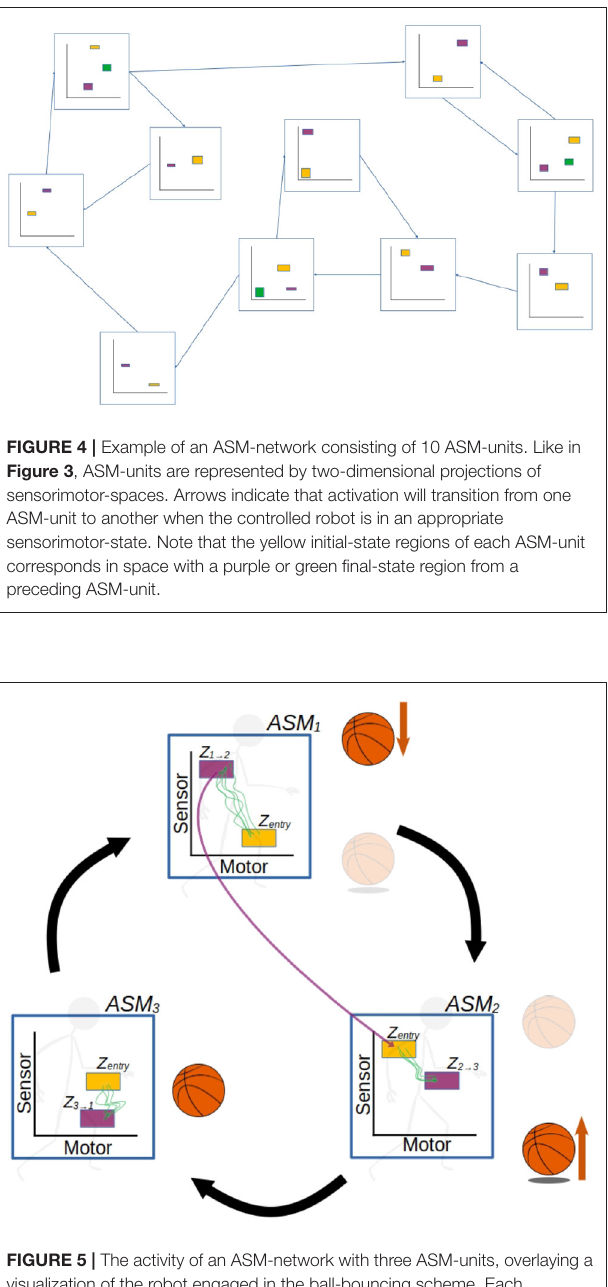
FIGURE 5 | The activity of an ASM-network with three ASM-units, overlaying a visualization of the robot engaged in the ball-bouncing scheme. Each ASM-unit simulates a particular sequential component of the dynamics involved in the robot’s side of the coupling. Each activation of the ASM-unit yields the necessary state for the activation of the next ASM-unit in the sequence. The progression of activations through the network mirrors the temporal arrangement of coordinations in a scheme.